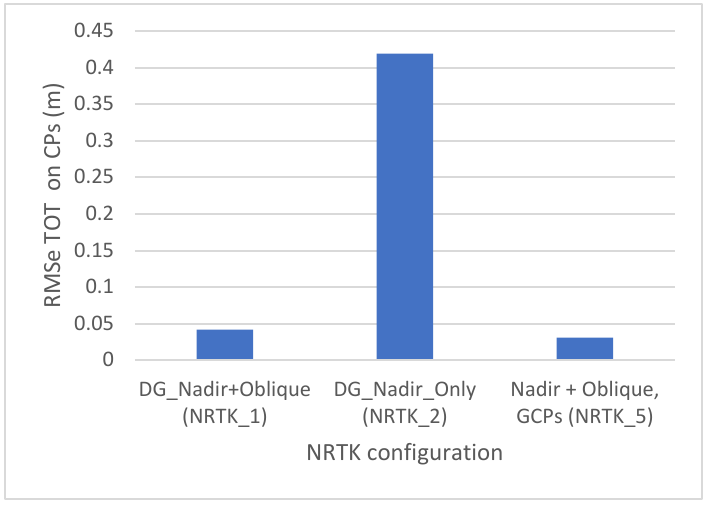
Figure 6. RMSE TOT of CPs for different NRTK configurations (NRTK_1, NRTK_2, and NRTK_5).